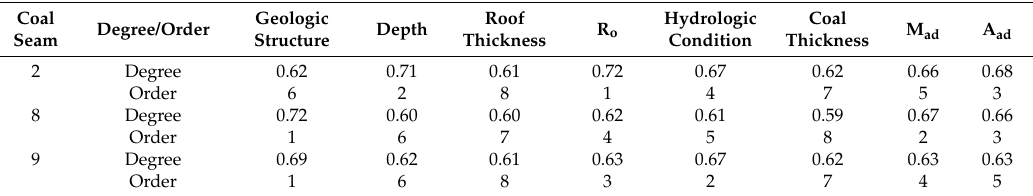
Table 3. The correlation degree between the reference sequence and the compared sequence associated with an ordering of correlation degree for Nos. 2, 8, and 9 coal seams.